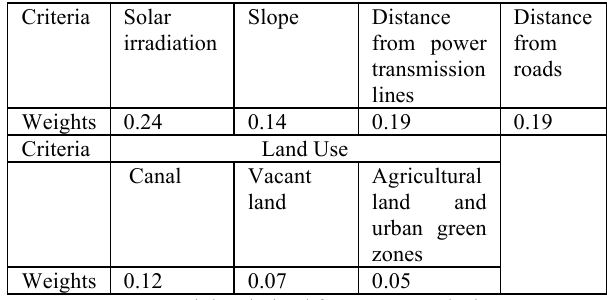
Table 2 . Weights derived from AHP